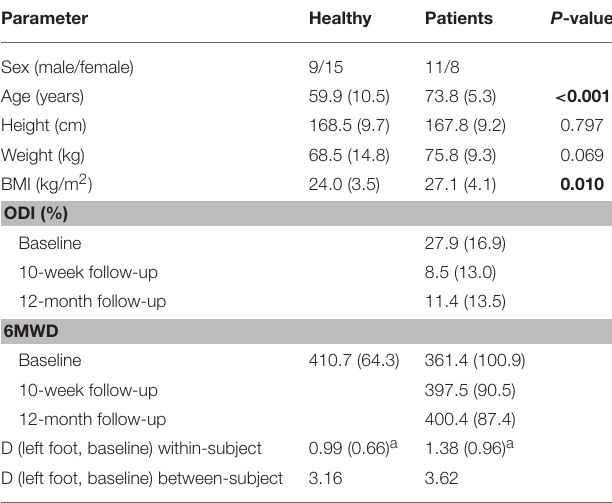
TABLE 1 | Mean (1 standard deviation) demographic information of